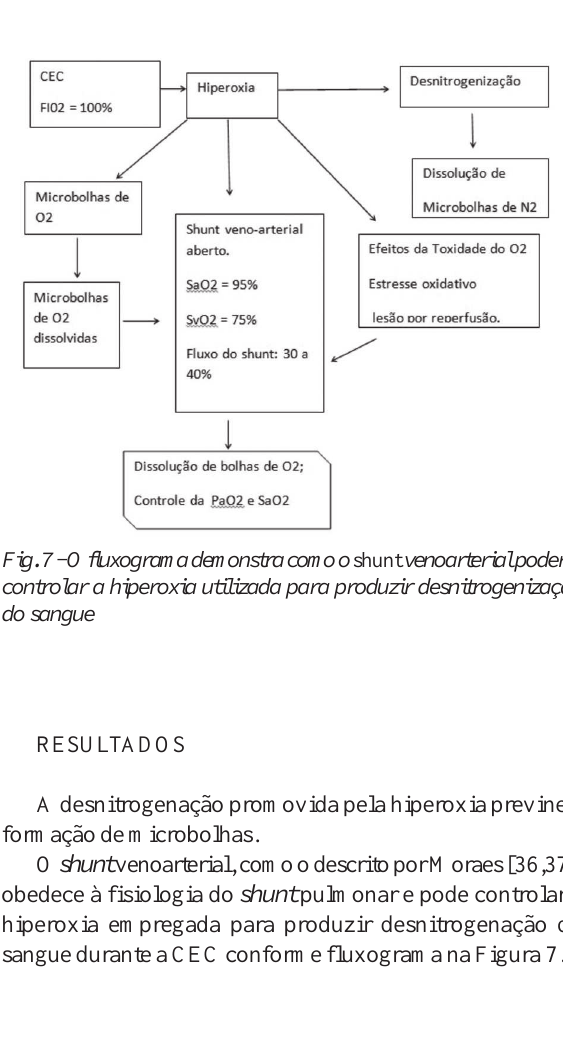
Tabela 5. Relação entre diâmetro, volume e área de superfície da microbolha de N Diâmetro da bolha